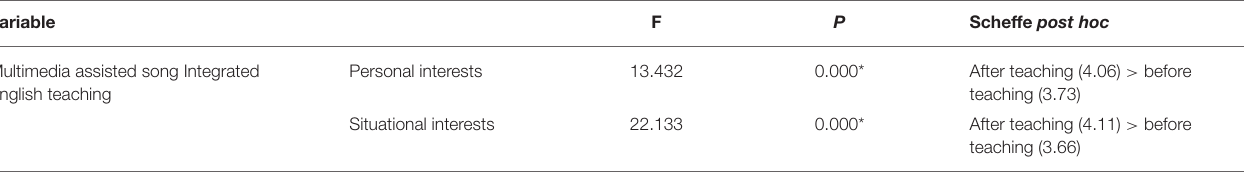
TABLE 1 | Difference analysis of multimedia assisted song integrated English teaching in terms of learning interest. Variable